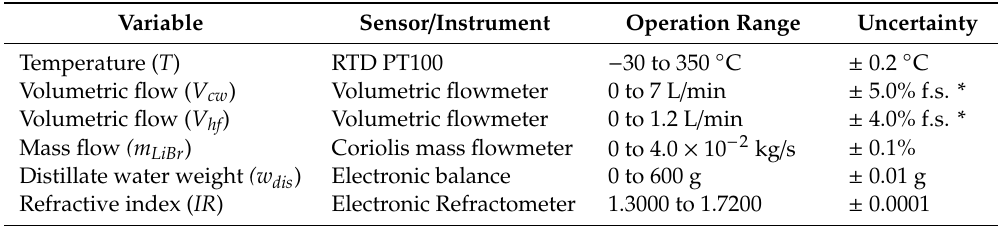
Table 2. Uncertainty of the measured